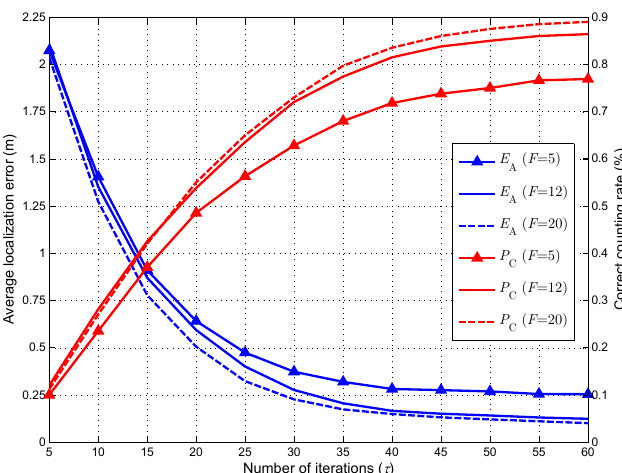
Figure 4. Counting and localization performance when the number of iterations varies from 5 to 60.